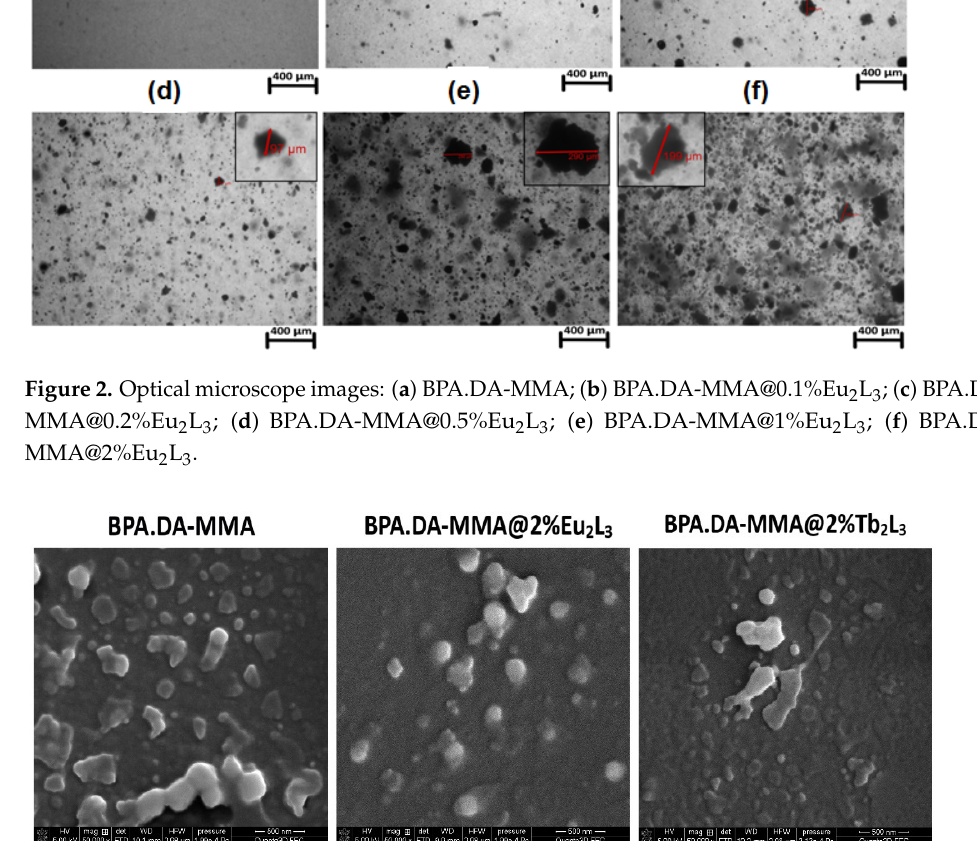
Figure 3. SEM images (1 μ m magnification) of free matrix and hybrid materials doped with 2 wt.% of Eu 2 L 3 and 2 wt.% of Tb 2 L 3 .